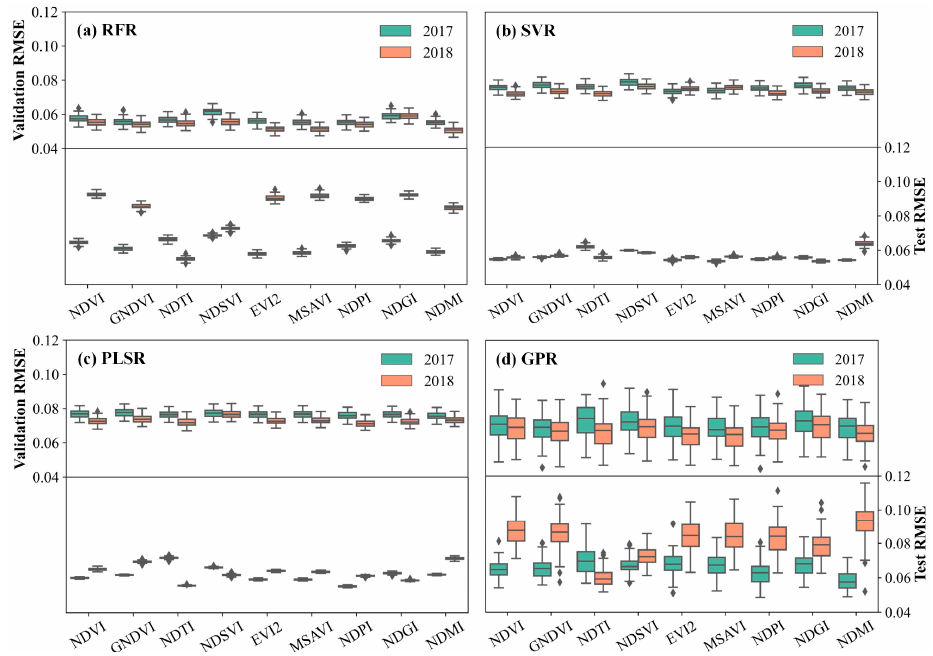
Figure 6. Validation accuracy and test accuracy of RFR ( a ), SVR ( b ), PLSR ( c ), and GPR ( d ) methods in the Middle subregion. Diamonds are outliers beyond the upper and lower quartiles by 1.5 times the interquartile range.